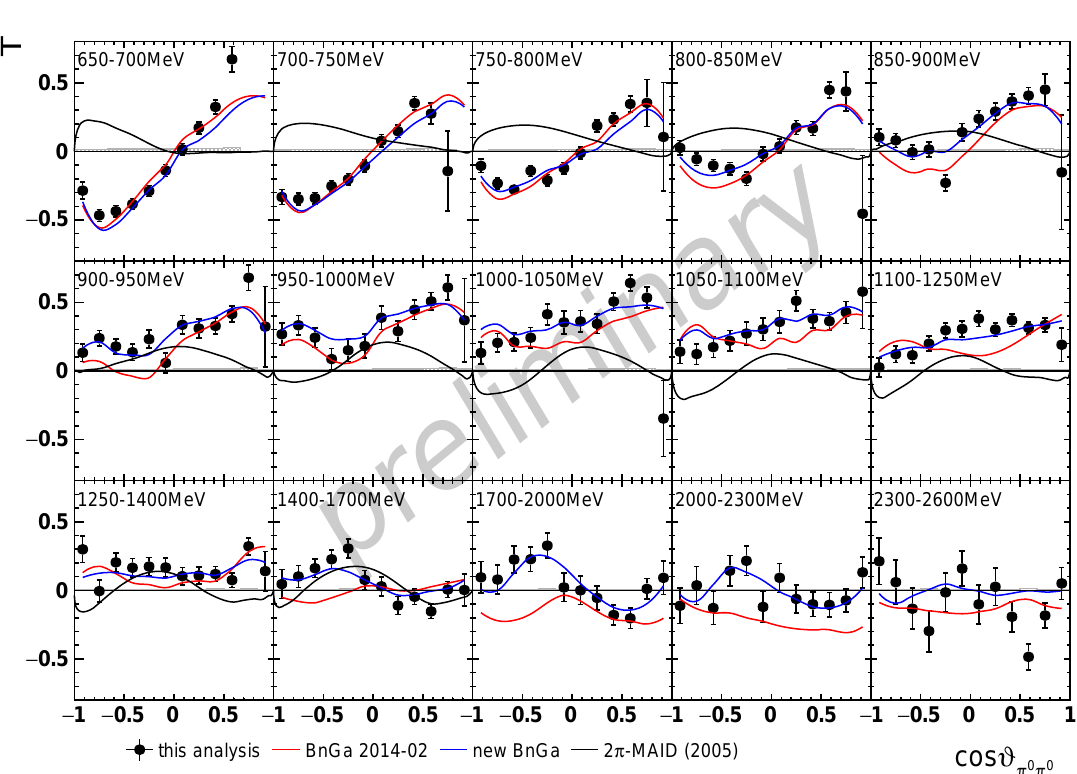
Figure 4. Targetasymmetry T as a function of beam energy E γ and cos ϑ π 0 π 0 .